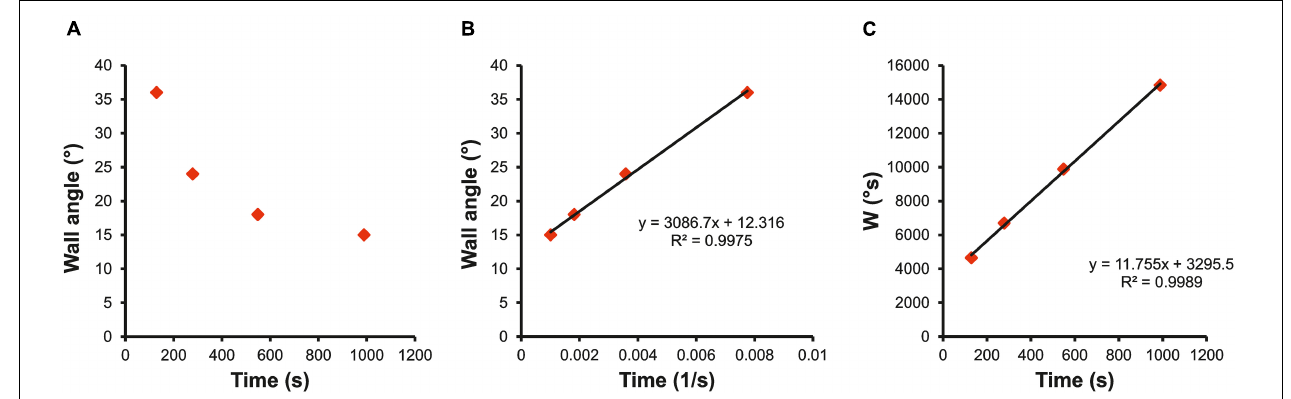
FIGURE 2 | Example of hyperbolic relationship between wall angle and TTE (A) and the calculation from linear models using (B) wall angle ( ◦ ) against time to failure (1/s); and (C) work limit W( ◦ s) against time to failure (s). Coefficient of determination ( R 2 ) indicates the fit of the linear model.